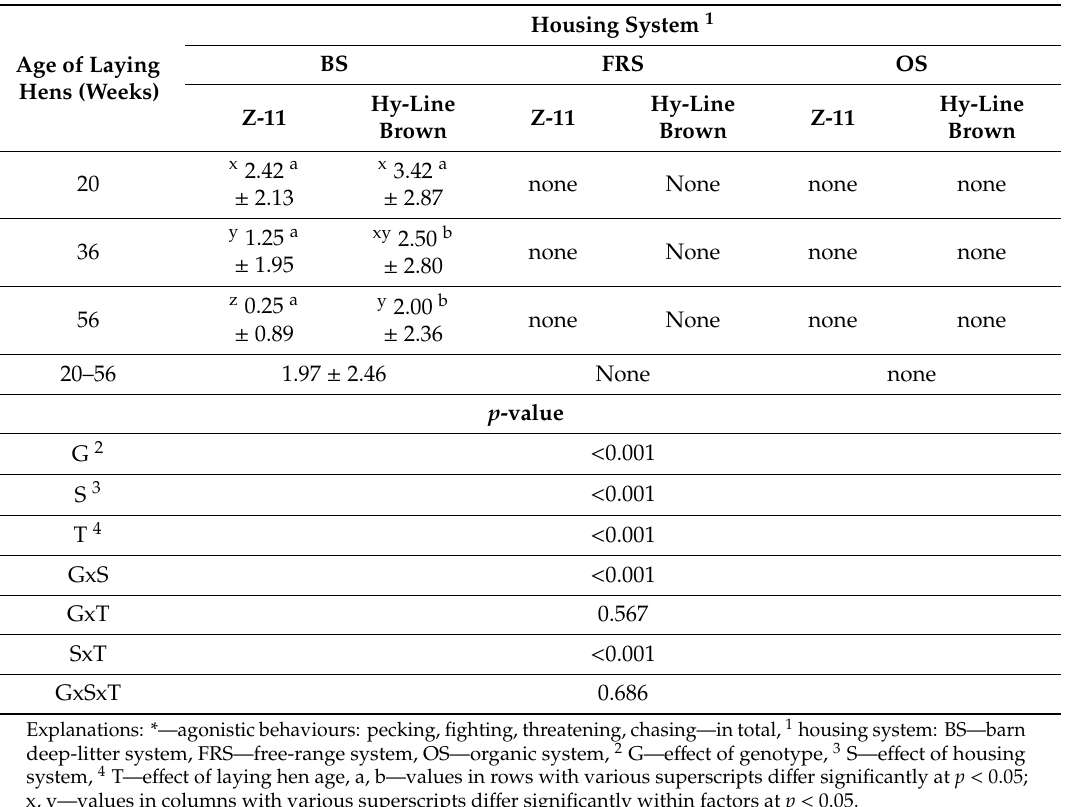
Table 4. Percentage of hens displaying agonistic behaviours *.